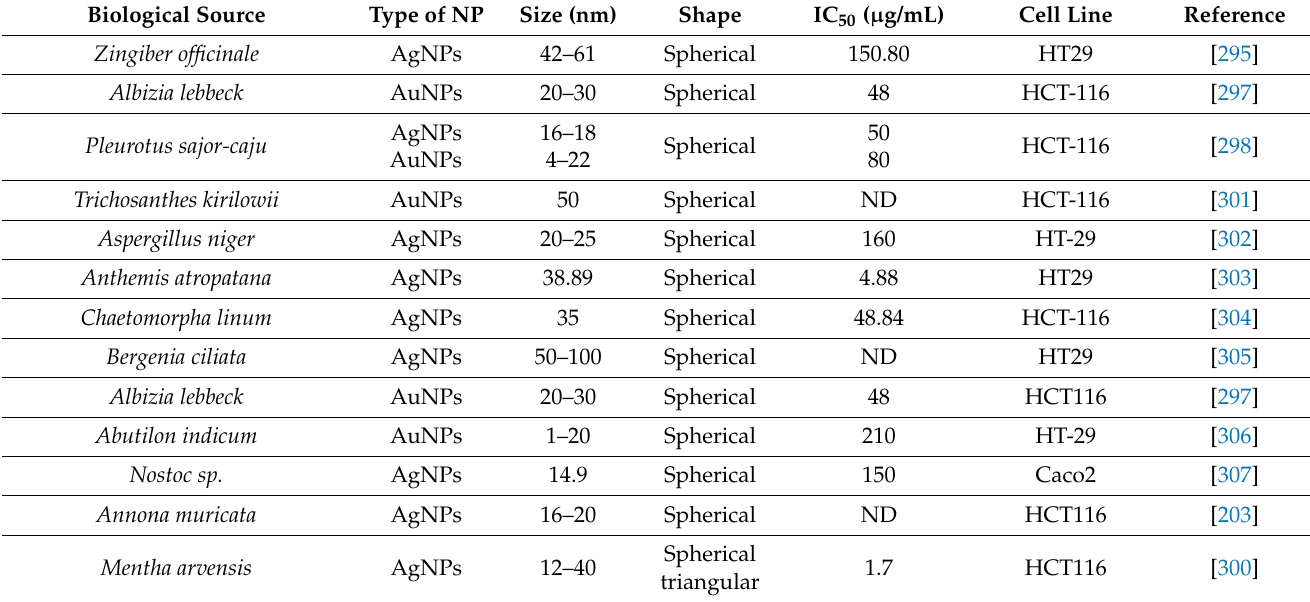
Table 9. Evaluation of green biogenic Au and AgNPs in colorectal cancer; biological source, NPs characteristics, IC 50 , and in vitro